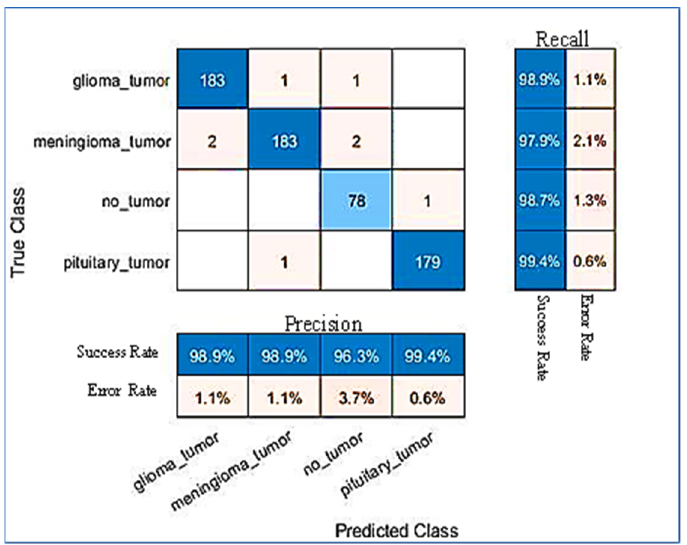
Electronics 2023 , 12 , x FOR PEER REVIEW 13 of 19 Figure 8. Results of SN-SVM method. Figure 8. Results of SN-SVM method.